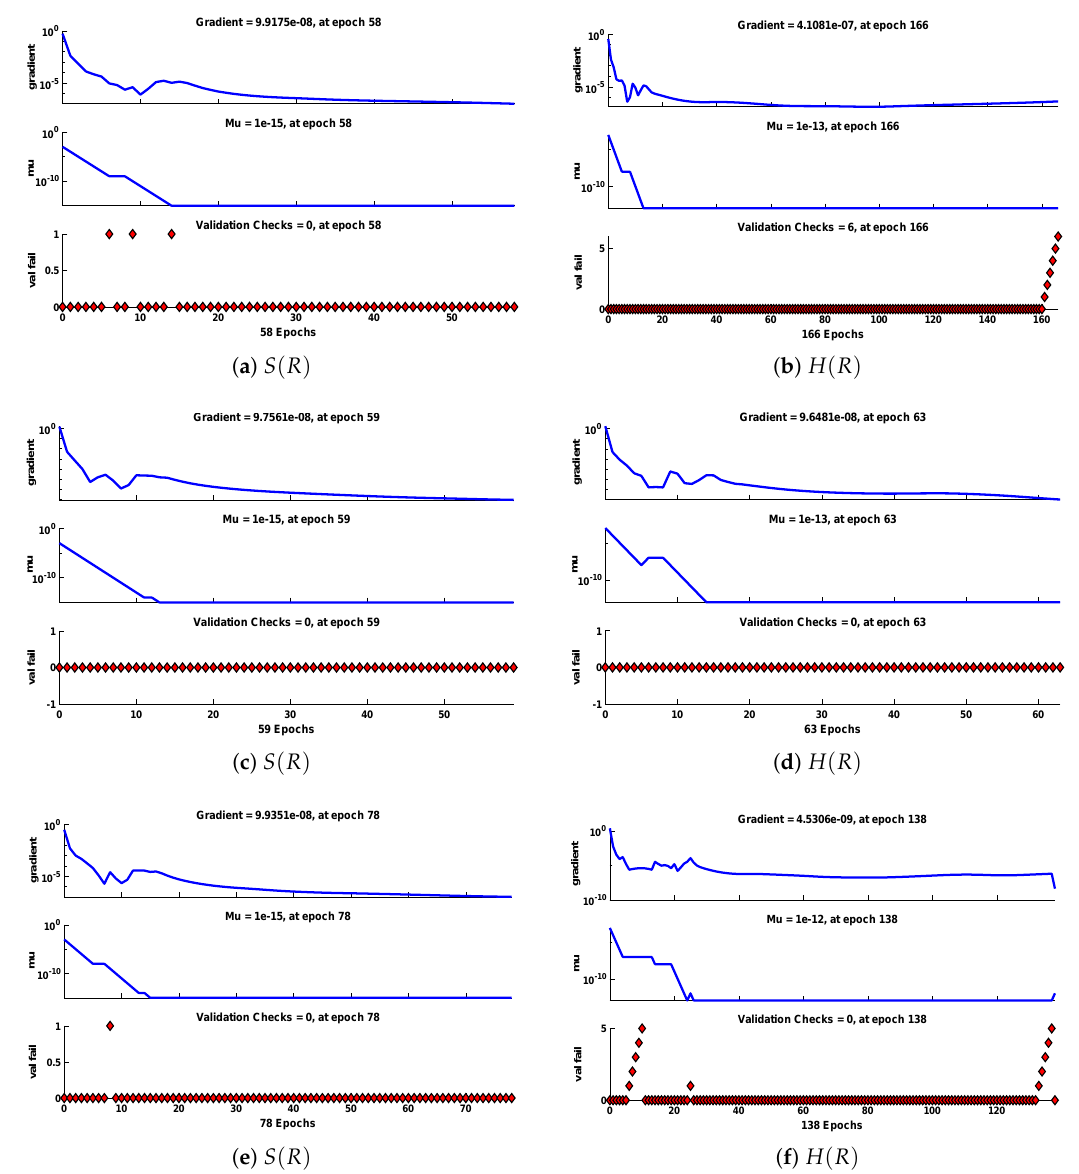
Figure 11. Performance of NNs–LM based on gradient, mu and validations failure during the process of optimization for different cases of Scenario